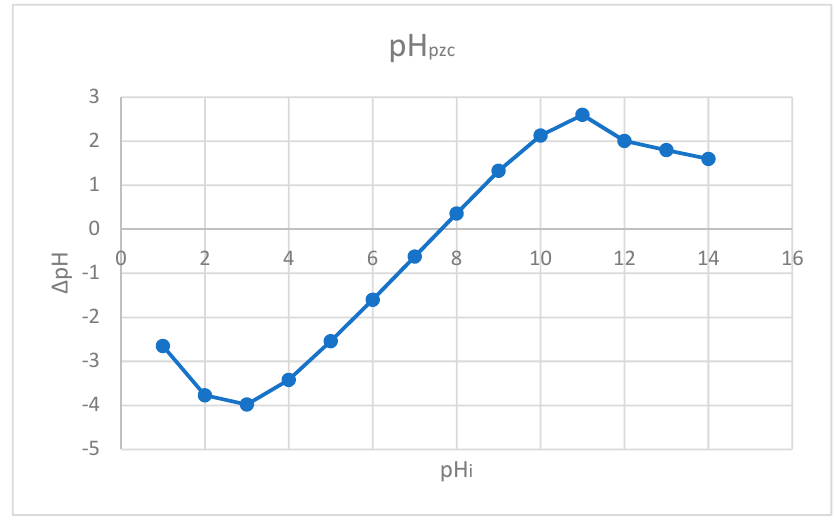
Figure 6. Dependence between initial and final pH of material surface.